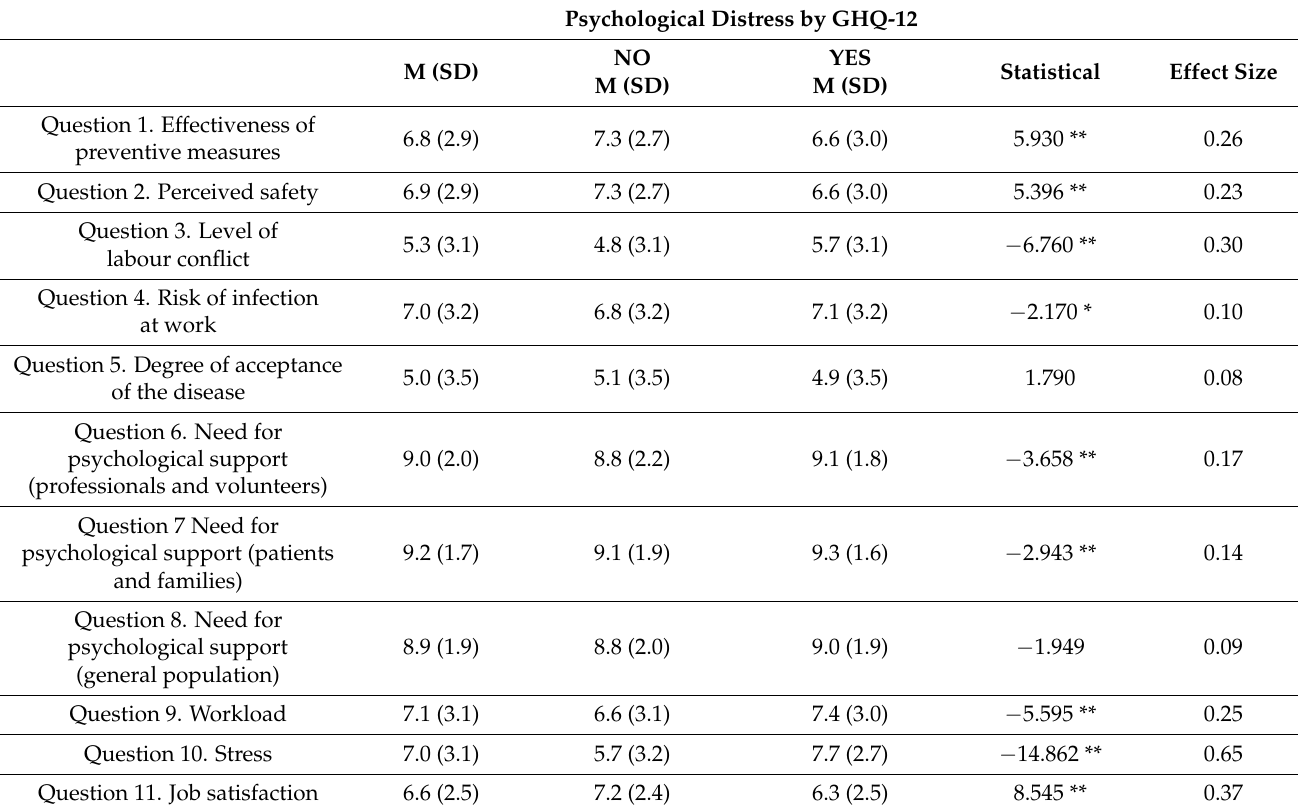
Table 5. The associations between work environment and psychological distress ( N =